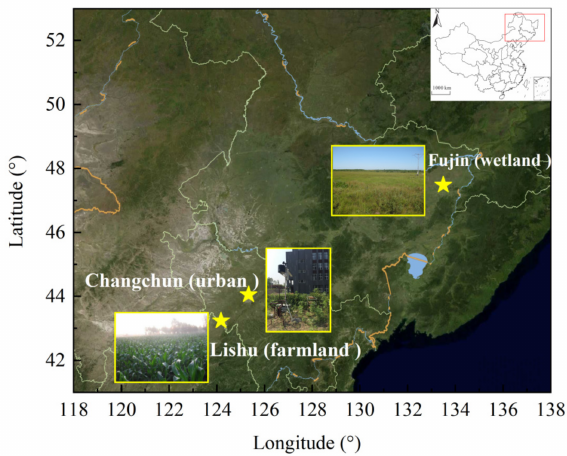
Figure 1. Distribution of sampling plots in Northeast China. Table 1. The climate characteristics and underlying surfaces in each sampling plot. Sampling Plots Ecosystem Underlying